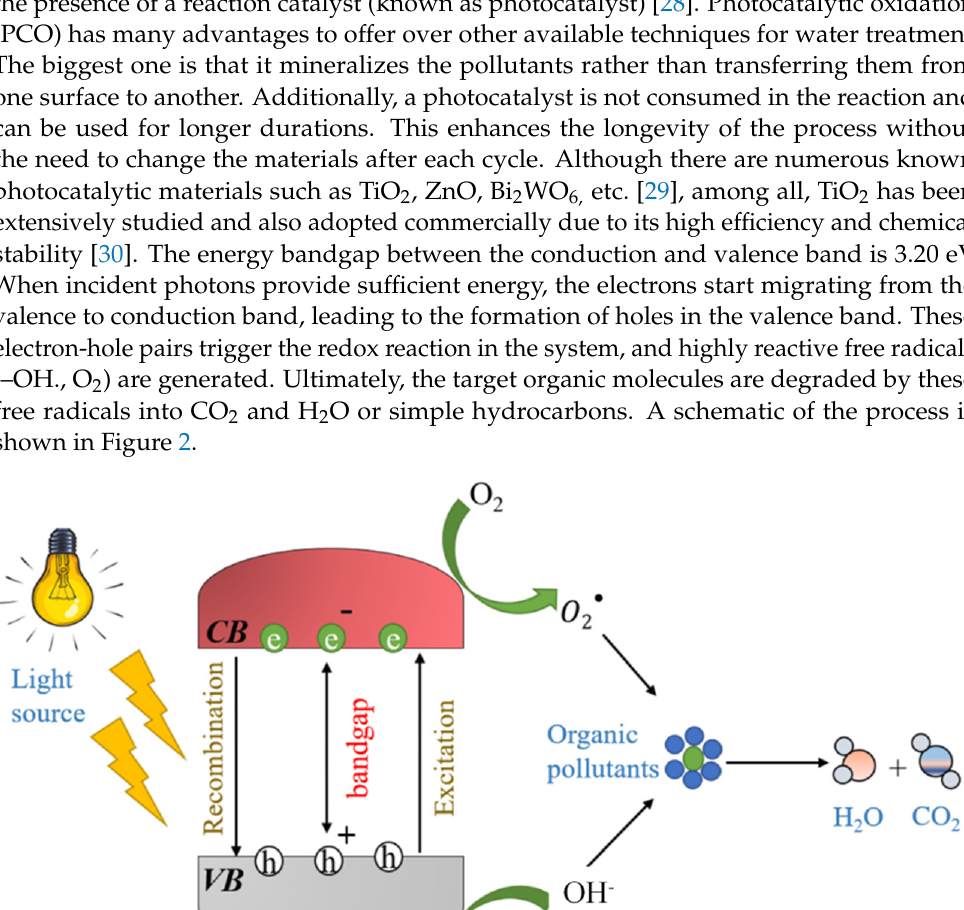
Figure 3. A schematic demonstrating various steps involved in photocatalytic bacterial disinfection. As discussed earlier, during a typical photocatalysis process, highly reactive free rad- icals are generated in the system. These free radicals are responsible for bacterial disinfec- tion by affecting multiple cell properties. Different mechanisms have been proposed by various researchers in the respective reports: (i) cell death due to oxidation of the intracel- lular coenzyme A (CoA) and (ii) decomposition of cell walls due to significant disorder in the cell permeability. Additionally, in one of the reports, Gogniat et al. suggested that